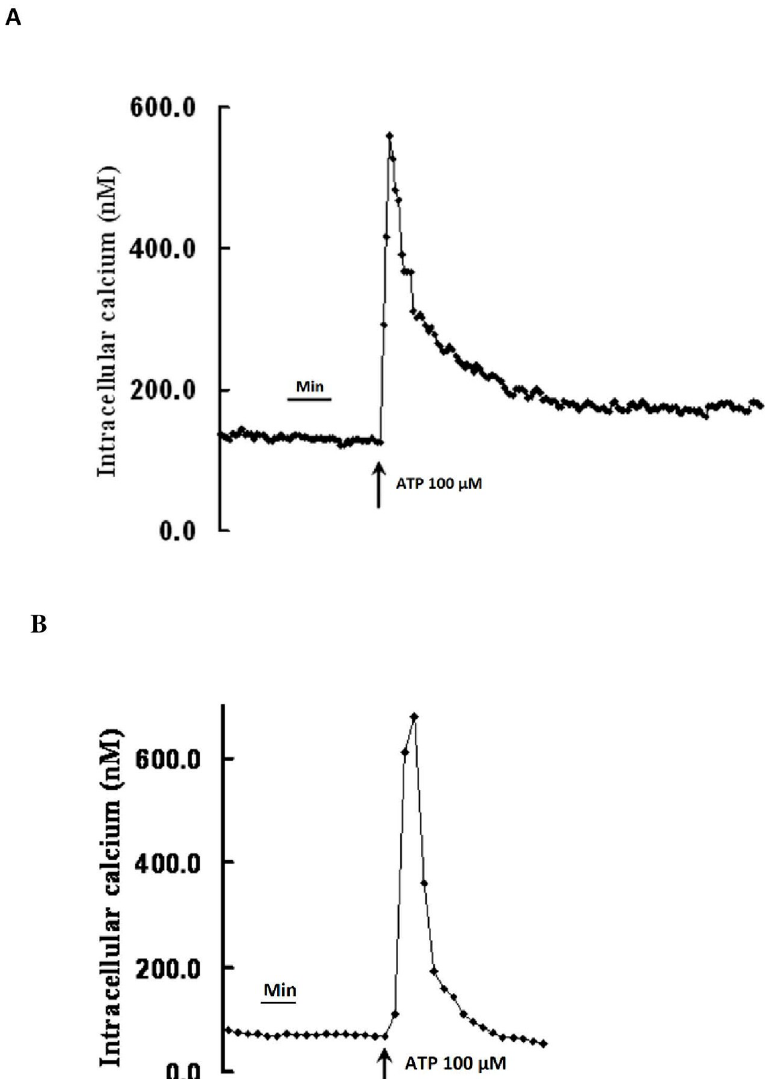
Fig 5. Increase in intracellular Ca 2+ in bovine cultured ciliary epithelial cells in response to ATP (100 μ M). (A) Typical trace, obtained in the presence of 1.8mM extracellular calcium, shows a rapid increase in [Ca 2+i ] i which is followed by a rapid decline and then a prolonged plateau above baseline. (B) Typical trace obtained in the absence extracellular calcium shows a rapid increase in [Ca 2+i ] i which is followed by a rapid decline to baseline without forming the